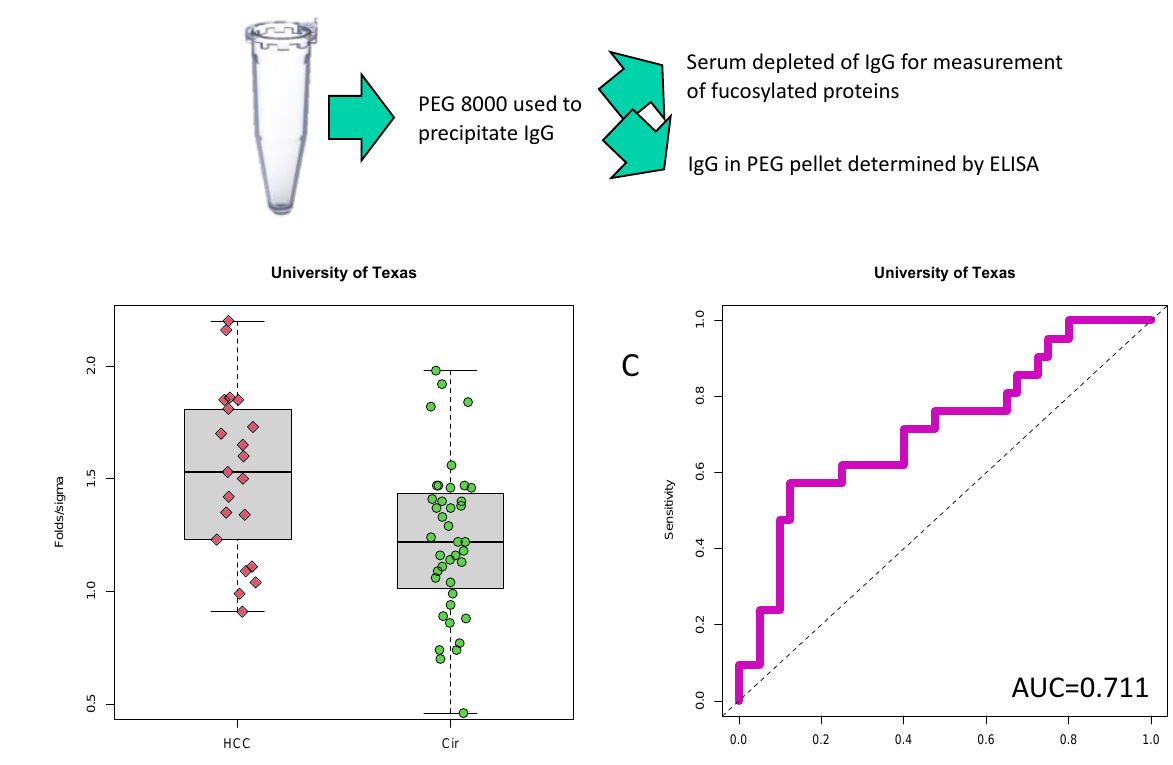
Figure 1. PEG-precipitated IgG is higher in HCC samples with cirrhosis when compared to cirrhosis without HCC. ( A ) Example workflow. PEG-8000 was used to precipitate heterophilic antibodies. The supernatant contained fucosylated glycoproteins of interest while the pellet contained IgG and other immunoglobulins. ( B ) Box and whiskers plot of PEG-IgG in 21 HCC or 40 cirrhosis samples (Cir). ( C ) AUROC of PEG-IgG which has a value of 0.711.